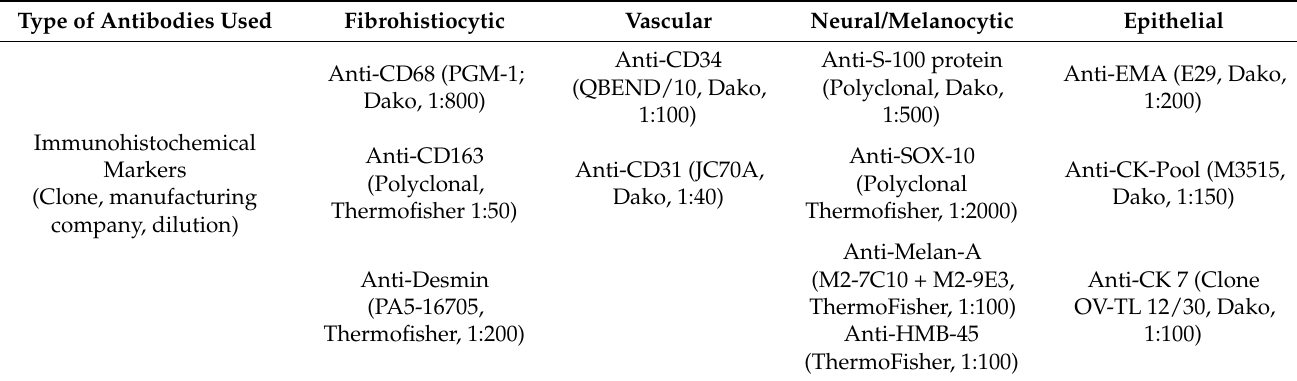
Table 1. Summary of antibodies used in this